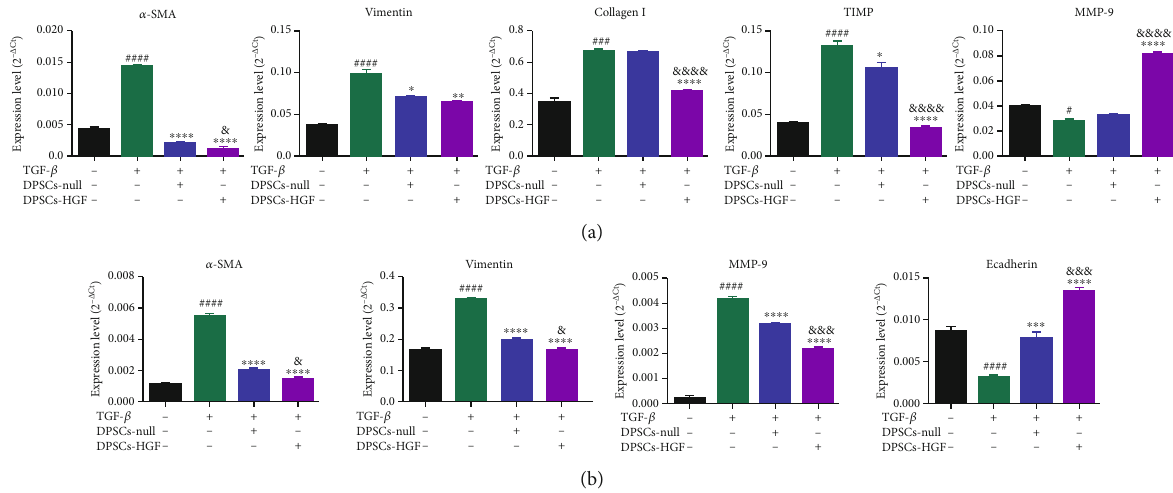
Figure 5: DPSCs-HGFs inhibit the fi brotic response in BEAS-2B and MRC-5 cells. (a) The expression of fi brotic factors, including α -SMA, vimentin, Col I, TIMP, and MMP-9, in MRC-5 cells stimulated with TGF- β was measured by qPCR. (b) The expression of fi brotic factors, including α -SMA, VIM, E-cadherin, and MMP-9, in BEAS-2B cells stimulated with TGF- β was measured by qPCR. Each experiment was performed in triplicate; the data are shown as the means ± SEM . ANOVA followed by Tukey ’ s multiple comparisons test was used to evaluate these data. # P < 0 : 05 , ### P < 0 : 001 , and #### P < 0 : 0001 vs. Con; ∗ P < 0 : 05 , ∗∗ P < 0 : 01 , ∗∗∗ P < 0 : 001 , and ∗∗∗∗ P < 0 : 0001 vs. TGF- β ; & P < 0 : 05 , &&& P < 0 : 001 , and &&&& P < 0 : 0001 vs. DPSCs-null. Con: control; DPSCs: dental pulp mesenchymal stem cells; α -SMA: α - smooth muscle actin; Col I: collagen type I; TIMP: tissue inhibitor of metalloproteinase; MMP-9: matrix metalloproteinase